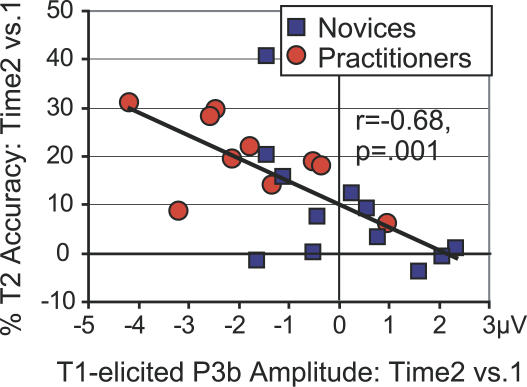
The Ability to Accurately Identify T2 Depends upon the Efficient Processing of T1Relationship between the change in attentional-blink magnitude over time and the corresponding change in T1-elicited P3b amplitude (for no-blink trials). Note that those individuals that showed the largest decrease in T1-elicited P3b amplitude over time generally showed the largest increase in T2 accuracy over time.